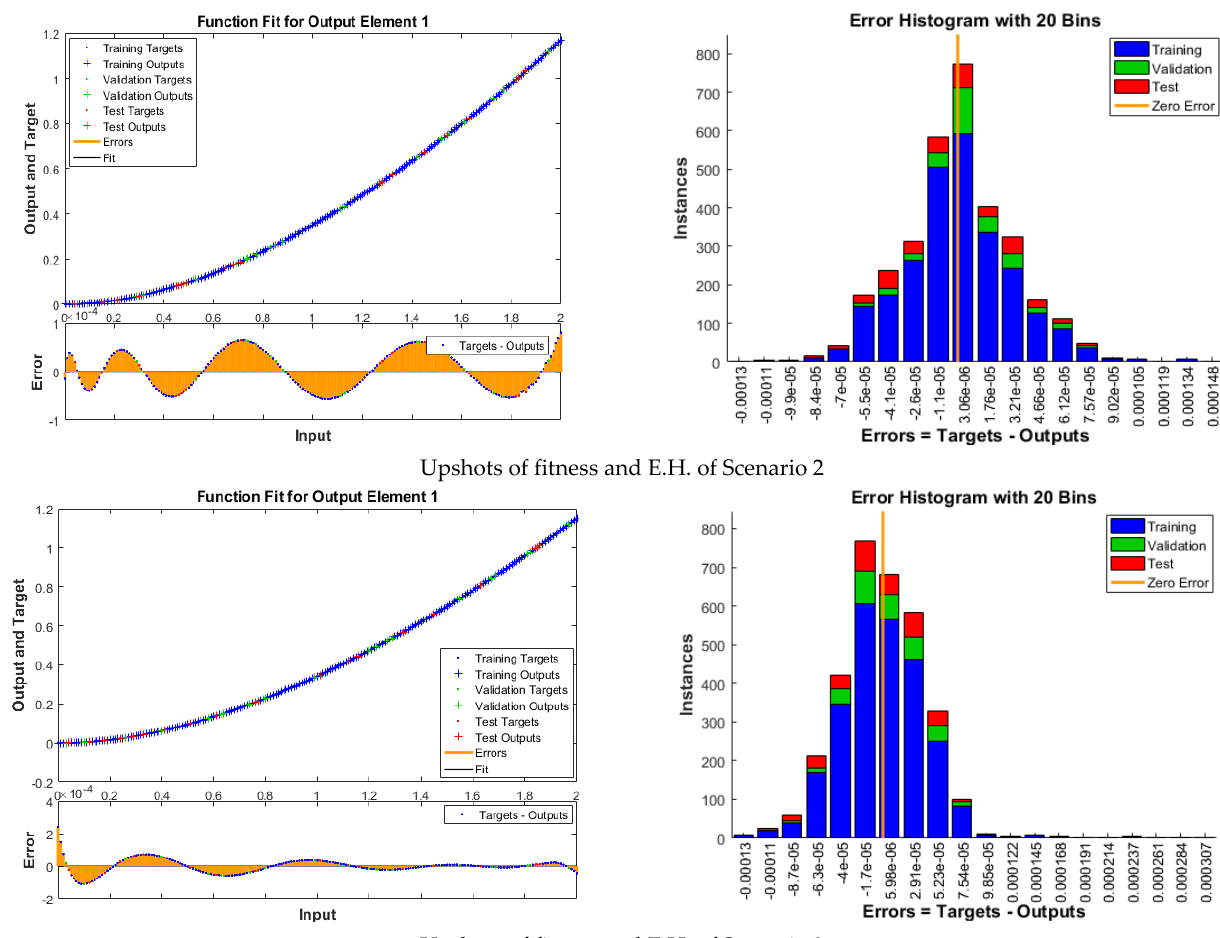
Figure 7. Solution of fitness and error histogram of proposed TLMB-NN for solving HTM-BFN model with MHD for scenarios 1–3.